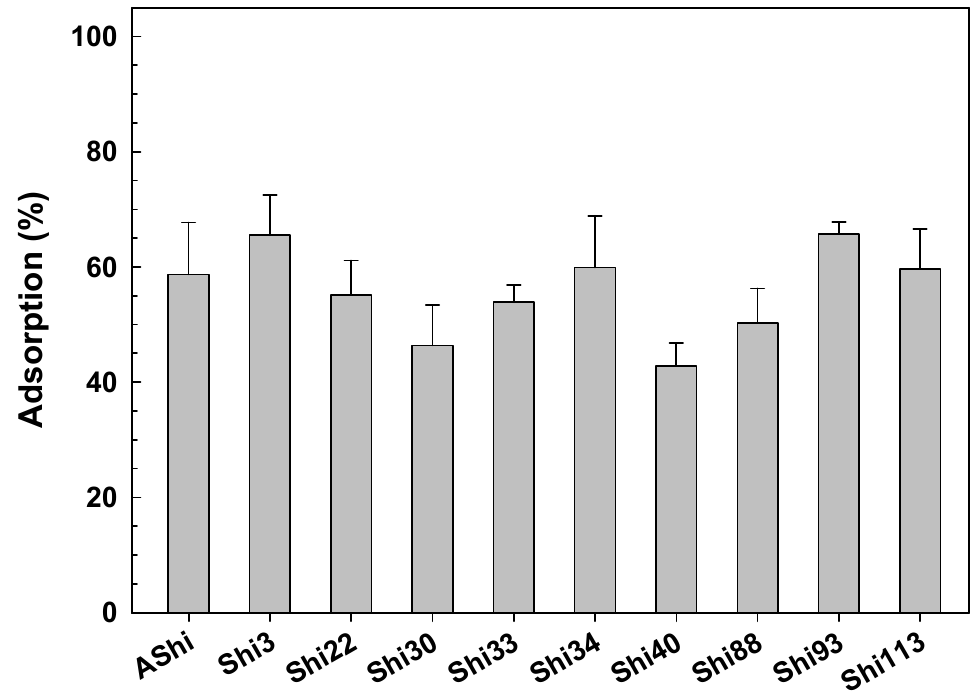
Figure 7. Phage adsorption in meat at 25 °C on ATCC12022 viable cells. Values are the mean ± standard deviation (error bars) of three determinations.